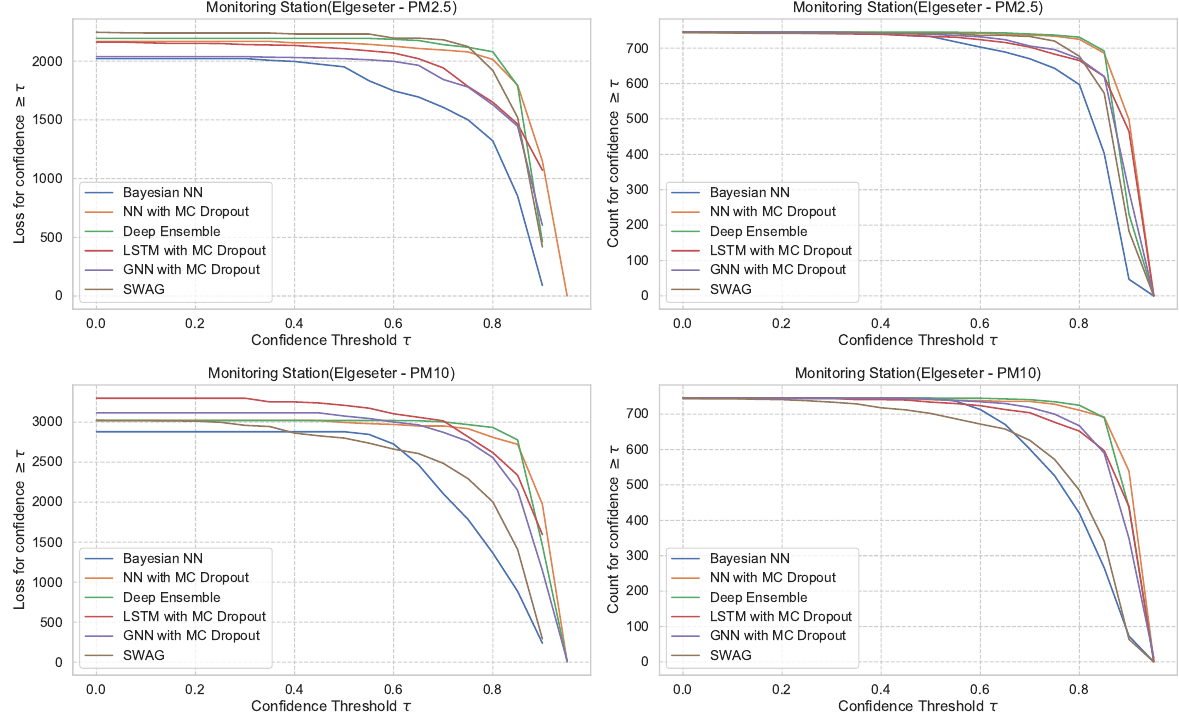
Figure 28. Comparison of confidence reliability for the selected probabilistic models in the PM-value regression task. ( Left: ) loss versus confidence. ( Right: ) count versus